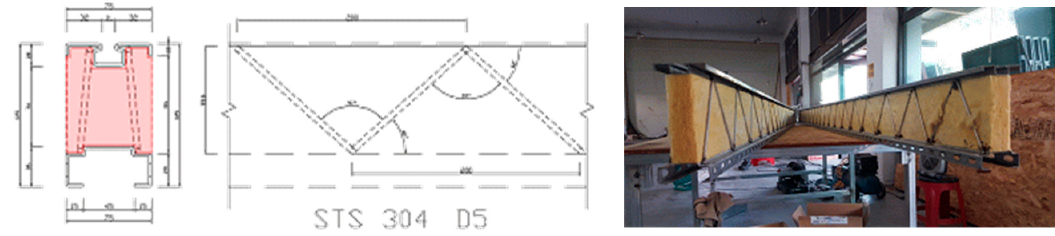
Figure 1. Truss insulation frame (TIF).